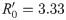
Surveillance data of the compartments for the new strain equilibrium where the system is originally in endemic equilibrium with Disease 1.The reproduction number of the original strain is R0 = 3, while the reproduction number of the emergent strain is R0′=3.33. The vaccination rate used is 0.5.